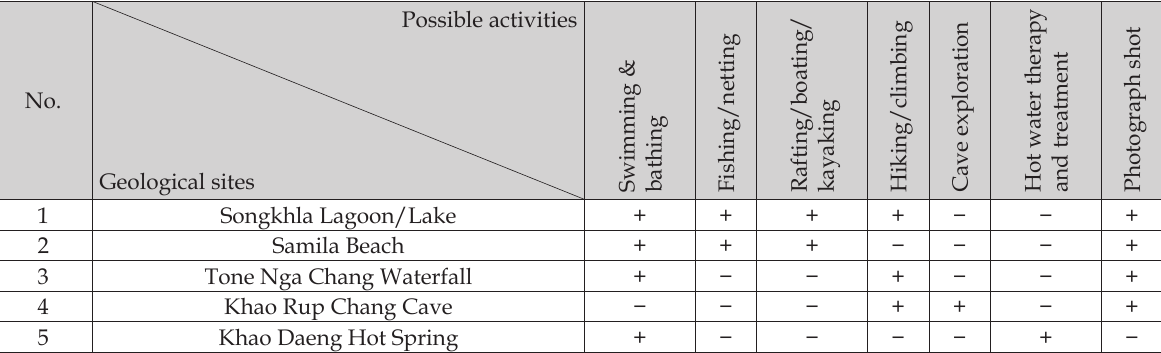
Table 6. Some possible tourism activities of some geosites in Songkhla Province, Thailand.